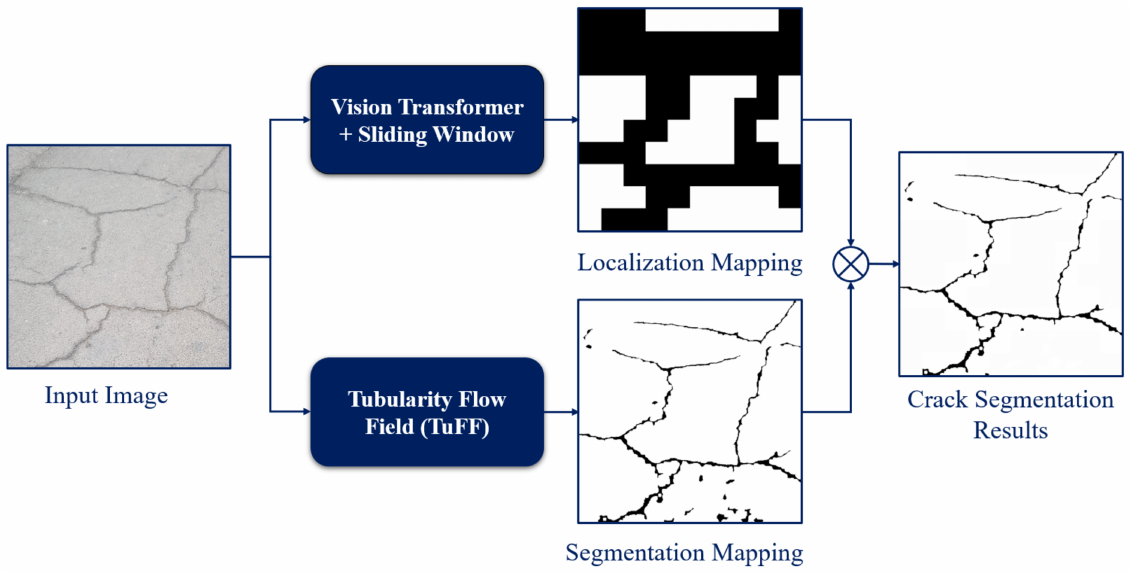
Figure 6. Representation of the Crack-Segmentation result after combining the TuFF result with localization mapping obtained from the sliding-window-based